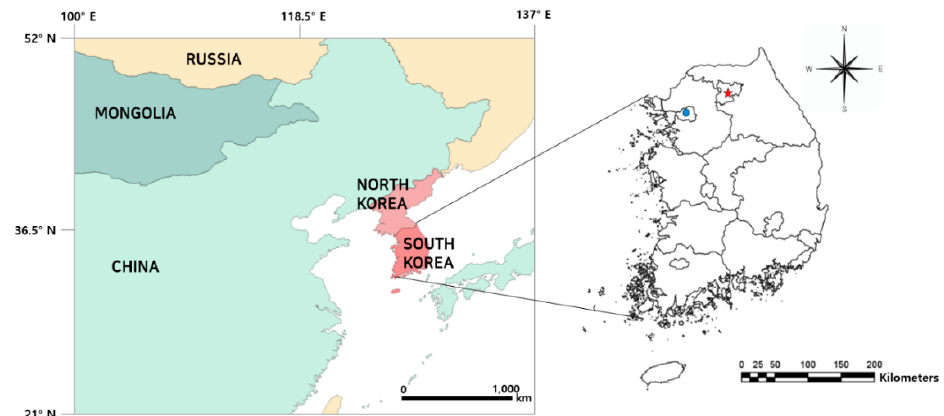
Figure 1. Sampling site used in this study. Location of South Korea ( left ). Map of South Korea ( right ). Red star indicates the location of the PM 2.5 sampling site in Chuncheon, and the blue circle indicates the national ambient air quality monitoring station in Seoul.